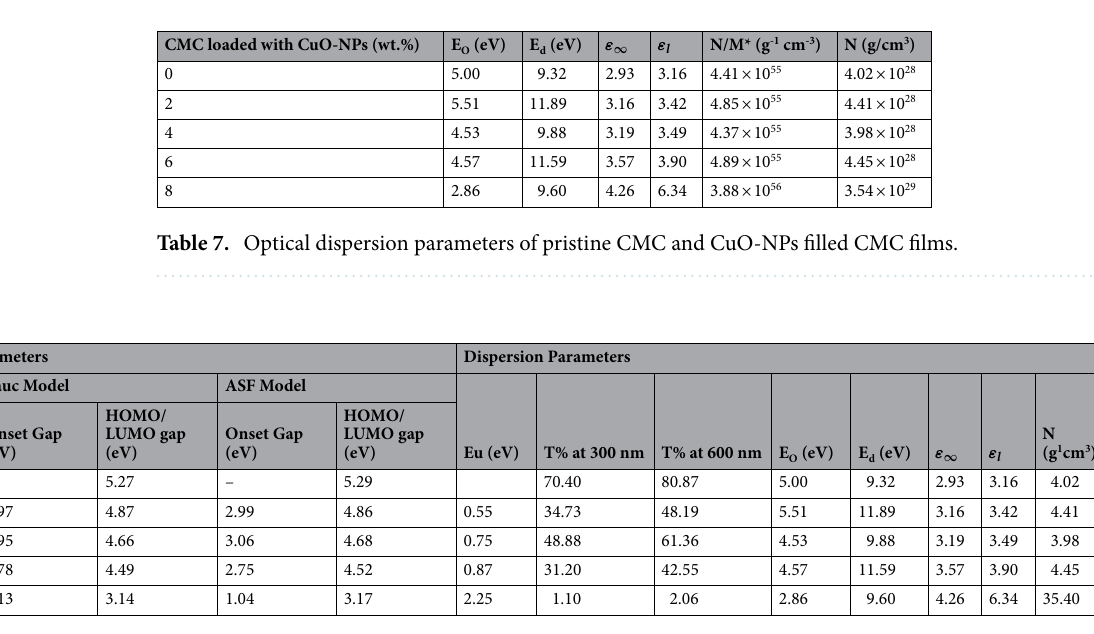
Table 8. Summarizes all of the optical parameters of CMC and CMC/ CuO nanocomposite